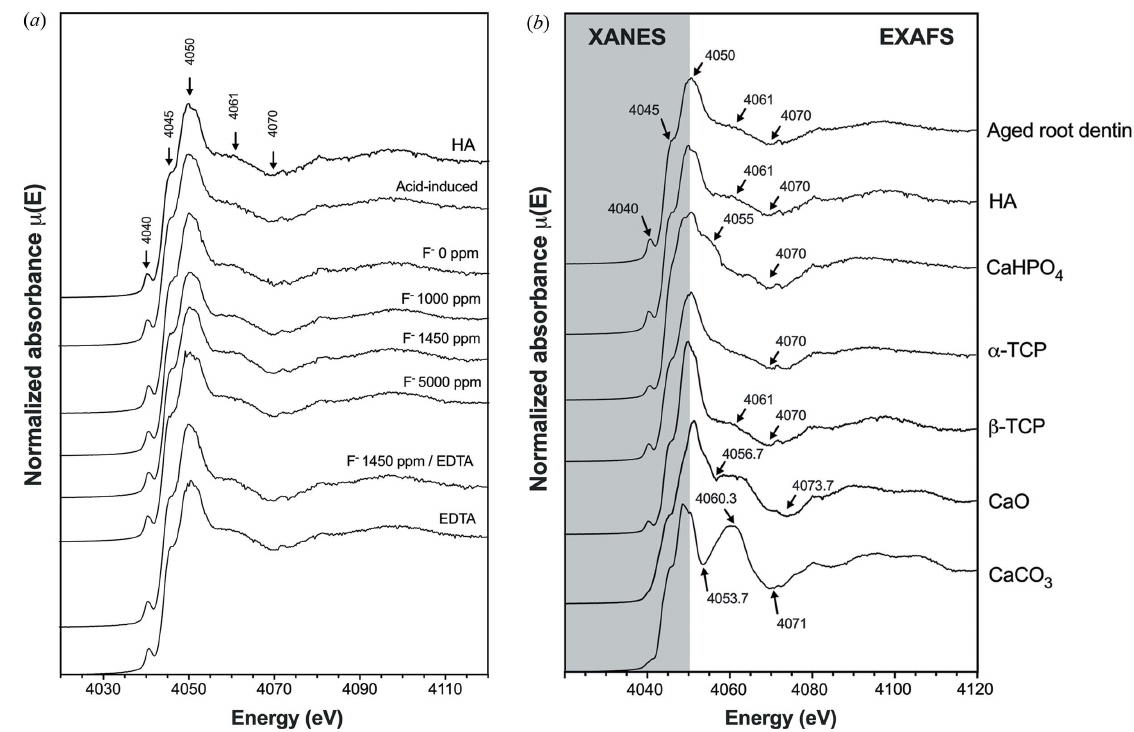
Figure 6 Spectral features of XAS consisting of X-ray absorption near-edge structure (XANES) specifically used for structural analysis and extended X-ray absorption fine structure (EXAFS). ( a ) The Ca-absorption edge obtained for each treatment group. ( b ) The structures in the absorption edge of the aged root dentin group strongly resemble the features found in the absorption edge of hydroxyapatite, indicating that hydroxyapatite is the main calcium species found in aged root dentin.